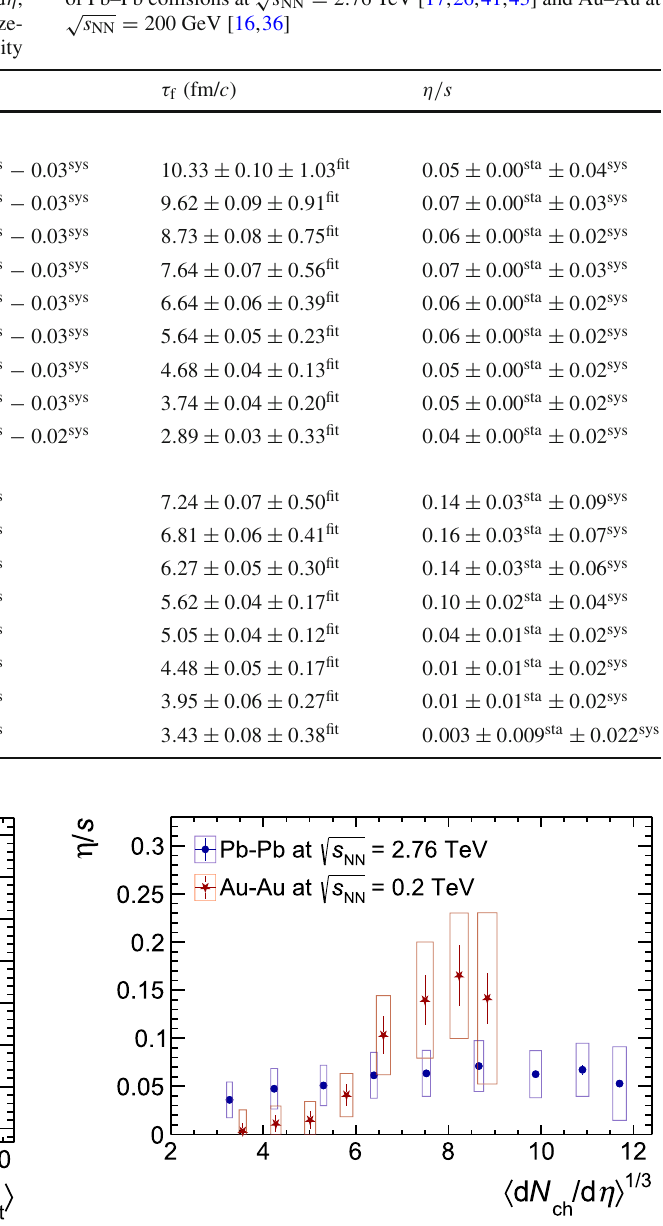
dence on ( d N ch / d η) 1 / 3 , while those from Au–Au colli- sions, measured at RHIC, show a rising trend with increas- ing ( d N ch /d η) 1 / 3 , albeit with large uncertainties. Values of η/ s obtained from Pb–Pb collisions are close but somewhat lower than the KSS bound of 1/4 π , while those obtained from Au–Au collisions are compatible with vanishing